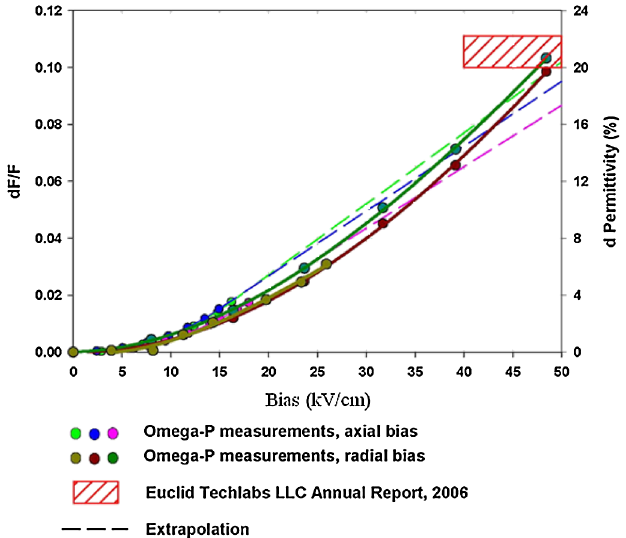
FIG. 4. Tunability measurements on modified BST ring. Note that one division on the right vertical axis is 4%.